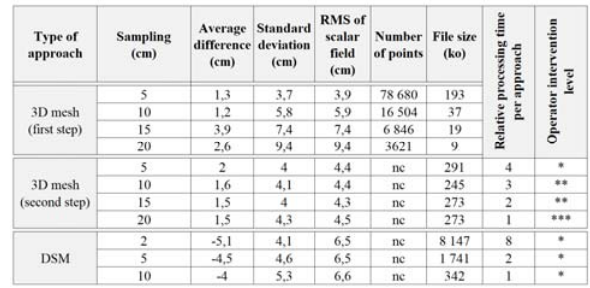
Table 2: Absolute comparison of meshes versus unsampled source point